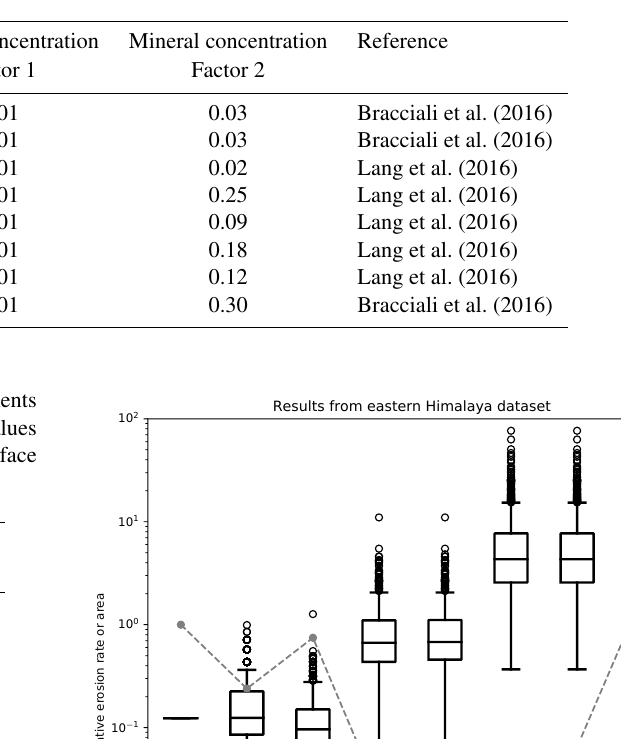
Table 2. Relative position along the main trunk of the Tsangpo–Siang–Brahmaputra river system. Negative numbers indicate samples col- lected along a tributary. Catchment areas and mineral concentration factors used to compute the erosion rate reported in Table 7. The two columns correspond to two different sets of values used for comparison. Site names refer to locations shown in Fig. 6.